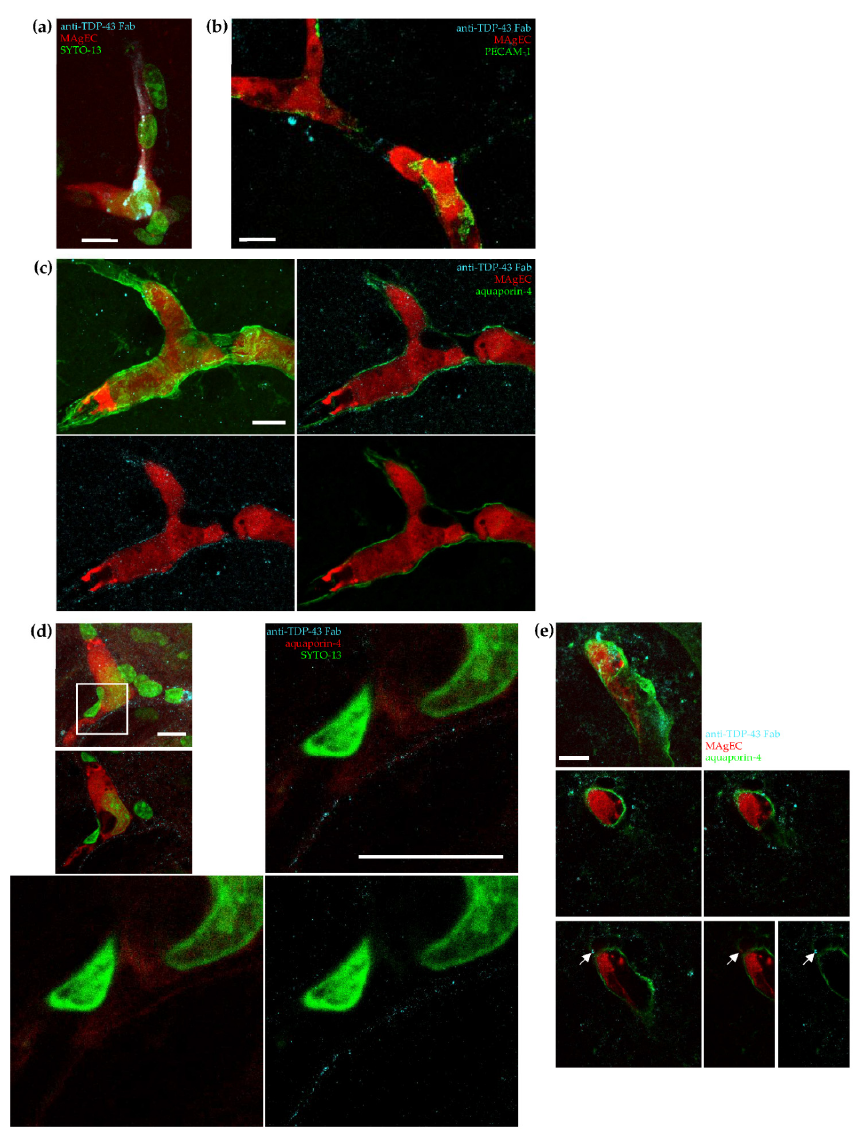
Figure 7. Exogenic TDP-43 antibody secreted by therapeutic MAgEC cells observed in the brain vasculature and brain parenchyma using confocal and super-resolution microscopy. ( a ) MAgEC 10.5 RT anti-TDP-43 cells expressing the fluorescent protein tdTomato (red) and anti TDP-43 Fab